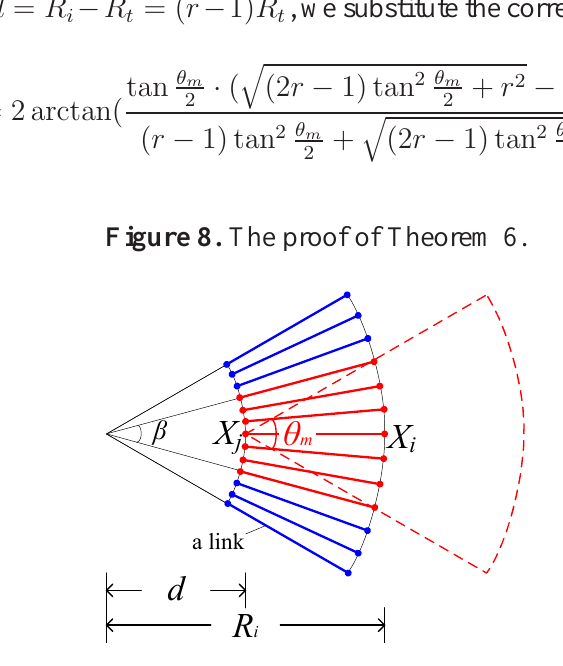
Figure 8. The proof of Theorem